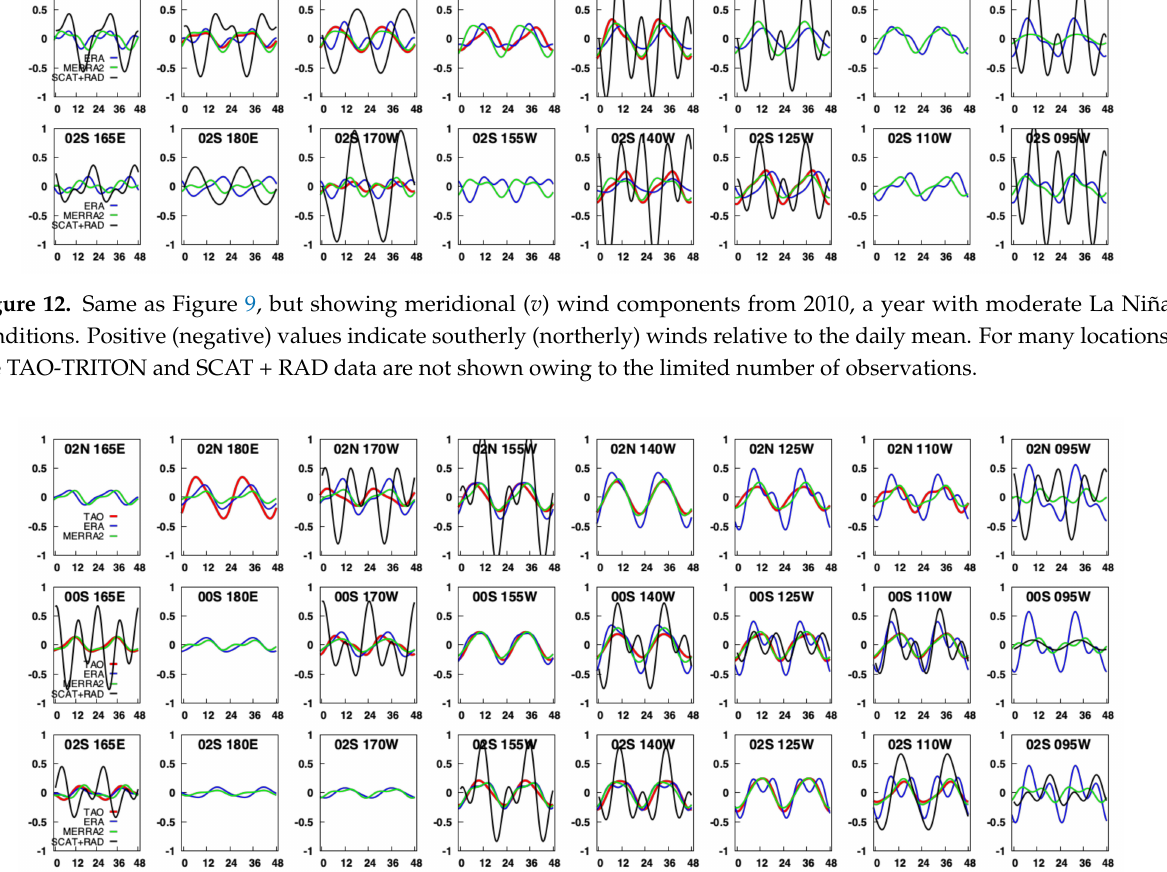
Figure 13. Same as Figure 9, but showing meridional ( v ) wind components from 2015, a year with strong El Niño conditions. Positive (negative) values indicate southerly (northerly) winds relative to the daily mean. For many locations, the TAO- TRITON and SCAT + RAD data are not shown owing to the limited number of